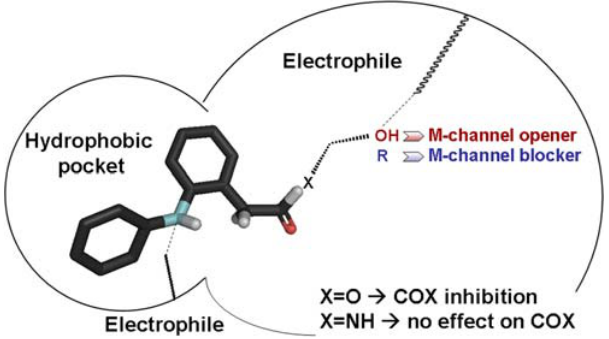
Figure 2. Pharmacophoric features of M-channels deduced from SAR studies of diphenylamine